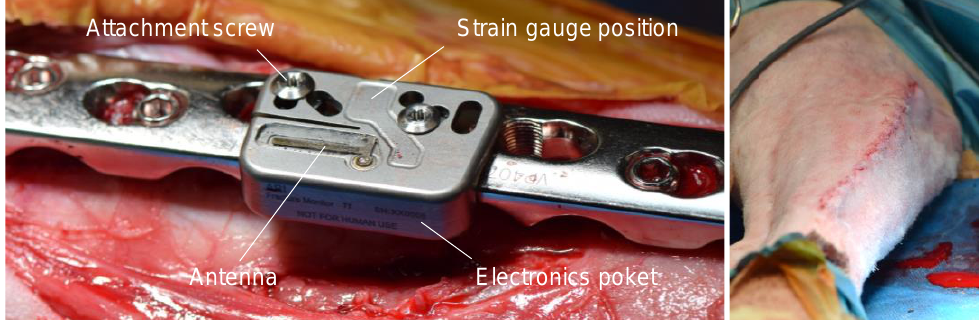
Figure 1. ( Left ): Implantable datalogger attached to a conventional stainless-steel locking plate with attachment screws and inserts (not visible) during surgery. Strain gauges are located in between the attachment screws to pick up implant load. The electronics pocket accommodates the electrical components and battery. An epoxy-potted antenna transmits data using the Bluetooth Low-Energy protocol. ( Right ): Sheep leg after wound closure above the